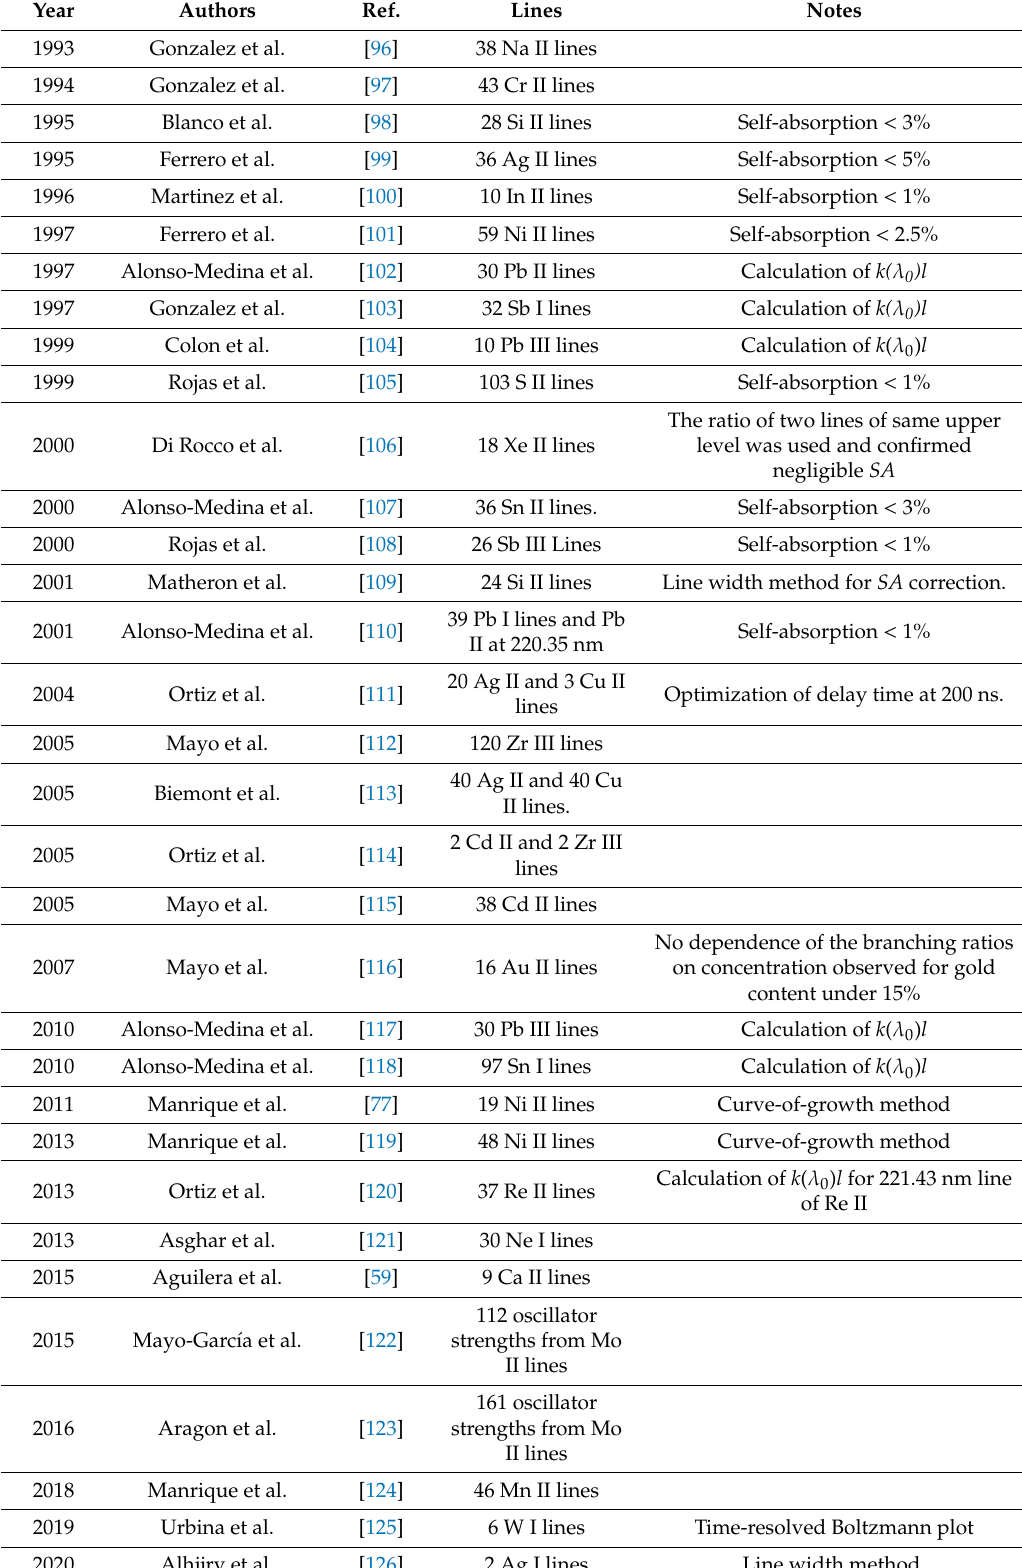
Table 2. Applications of LIBS for determining the transition probabilities of atomic